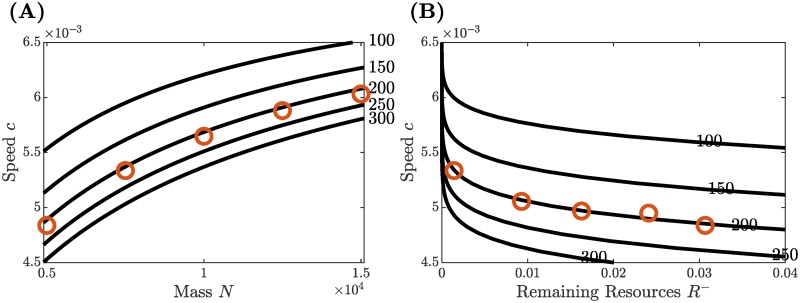
Level curves on which initial resources R+ are constant (black curves) computed explicitly from the analytic formulas of the PDE model, and numerical data points (orange circle) generated by direct simulation of the ABM.(A) Illustrates that the average swarm speed c monotonically increases with the mass N and shows agreement with numerical data obtained for N = 5000, 7500, 10000, 12500, 15000. (B) Illustrates the inverse relationship between c and R− and shows agreement with numerical data for N = 5000, 5250, 5500, 6000, 7500.